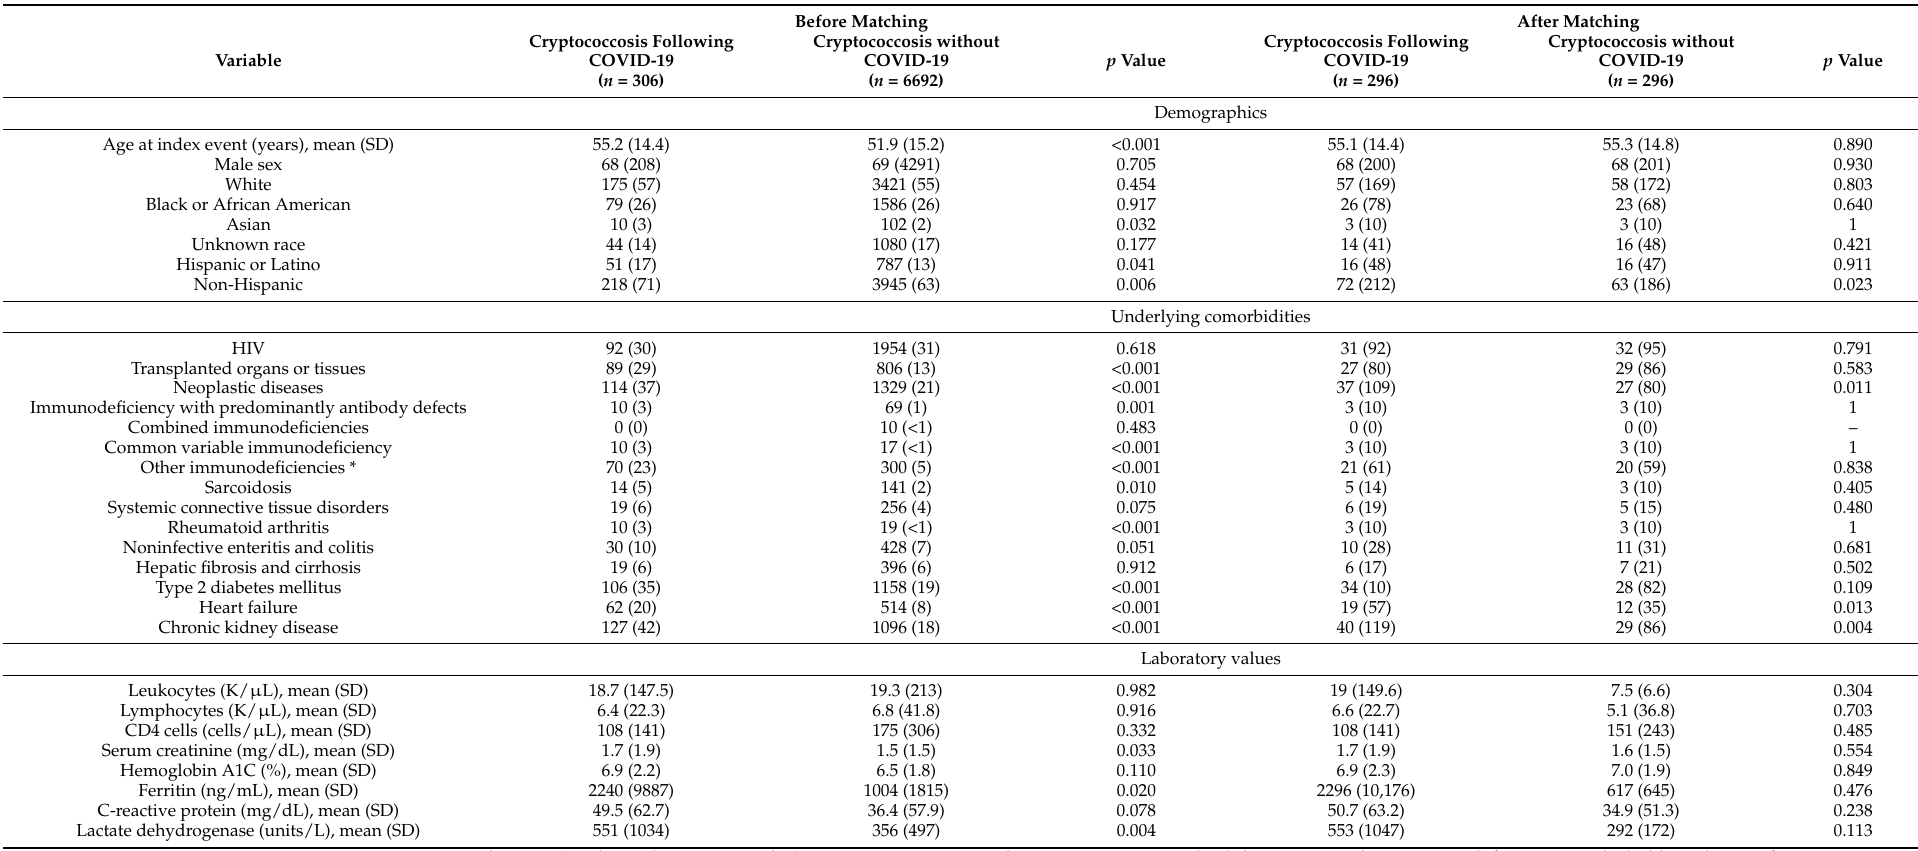
Table 1. Baseline characteristics of patients with cryptococcosis following COVID-19 compared to non-COVID-19 controls with